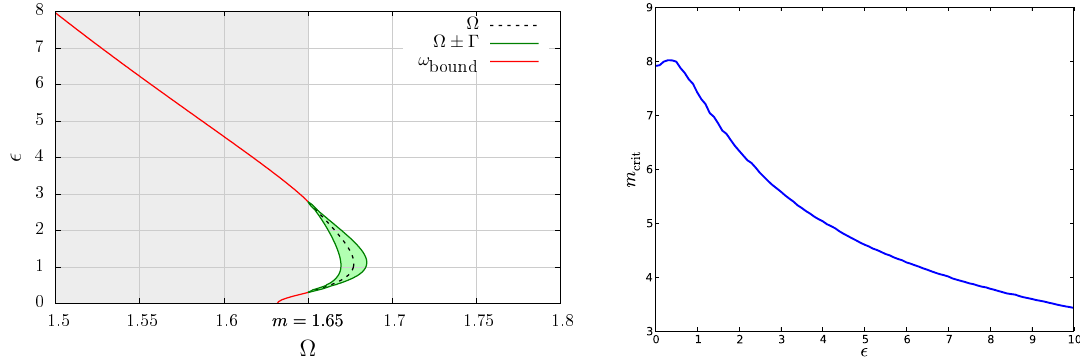
m = 1 . 65 Figure 14 . Left: the (cid:12)rst oscillating/resonance mode for m = 1 : 65. Right: value of the critical mass for the second oscillating mode.